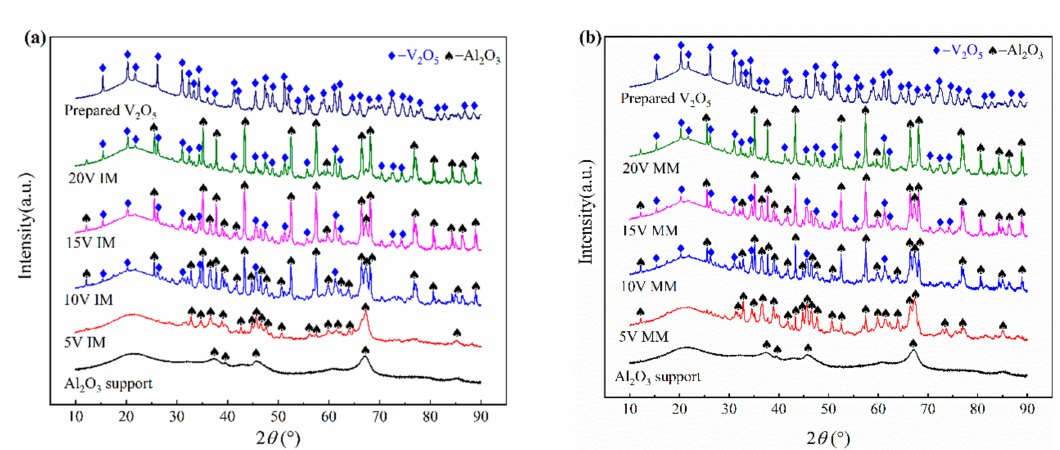
Figure 1. The X-ray diffraction (XRD) patterns of V-based oxygen carriers with different V loadings, Al 2 O 3 support and prepared V 2 O 5 : ( a ) Impregnation method; ( b ) Mechanical mixing